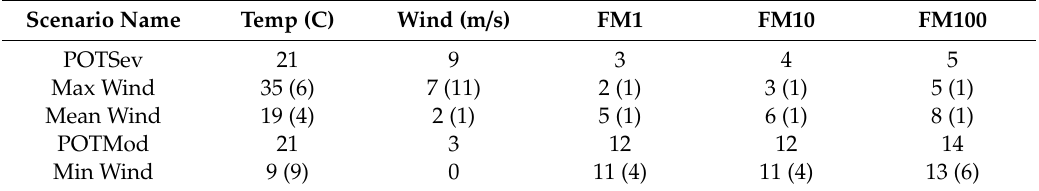
Table 3. Means and standard deviations (in parentheses, for the representative weather scenarios) of temperature, wind speed and fuel moisture parameters (% by weight for 1, 10 and 100 hr fuel moisture) used in Fire and Fuels Extension (FFE) model